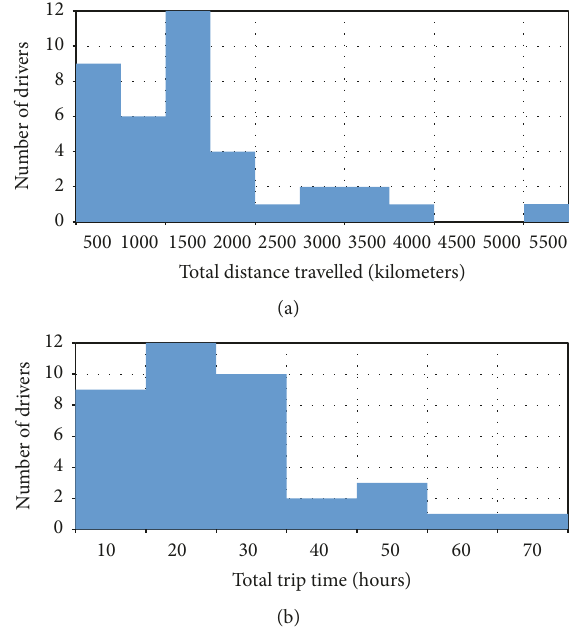
Figure 2: Distribution of total journey distance and time for the participants . (a) Histogram of total distance travelled by the drivers. (b) Histogram of total trip duration for the